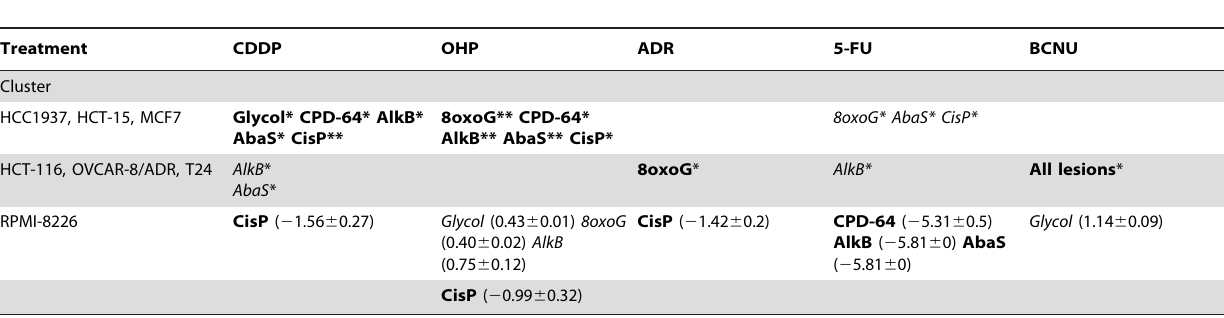
Table 1. Characteristics of the 3 cell line clusters in terms of DNA repair sub-pathway response to the drugs treatments (see Fig. 3).